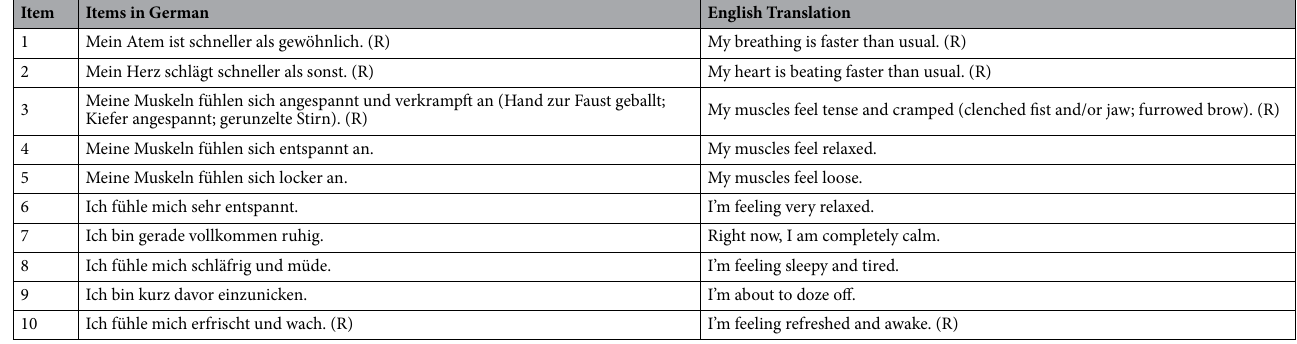
Table 1. Items and their English translation. Reverse-coded items are indicated by